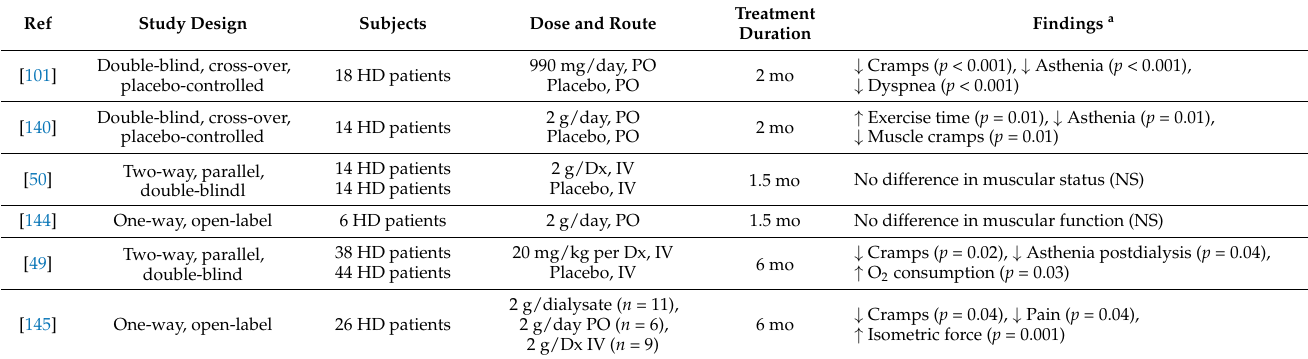
Table 3. Studies of the effect of levocarnitine on muscle symptoms and quality of life in dialysis patients.